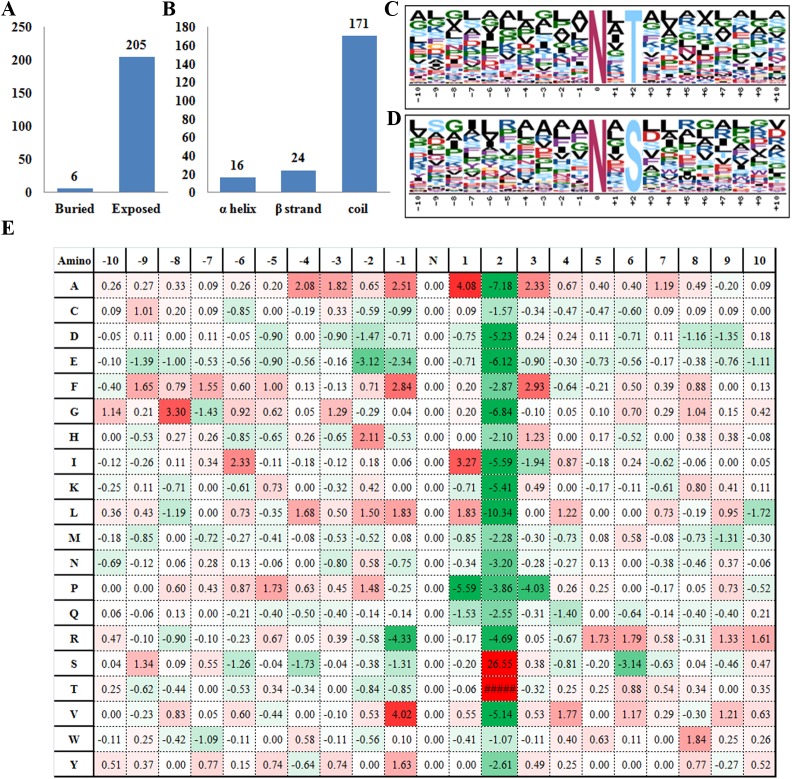
(A) Number of glycosites located on the buried or exposed region of the proteins; (B) Number of glycosites in different secondary structures; (C-E) Motif-X analysis of the over-represented motifs around the glycosites, (C) [NxT], (D) [NxS] (x can be any amino acids except proline). (E) Motif analysis of all the identified glycosites.